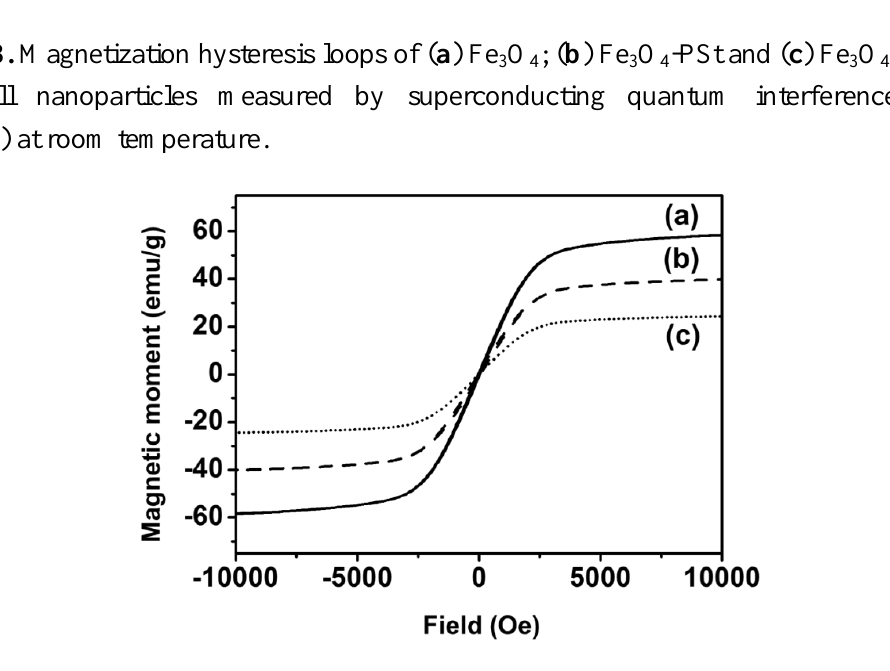
Figure 4. Transmission electron microscopy (TEM) micrographs of ( a ) oleic acid-stabilized Fe O nanoparticles; ( b ) Fe 3 4